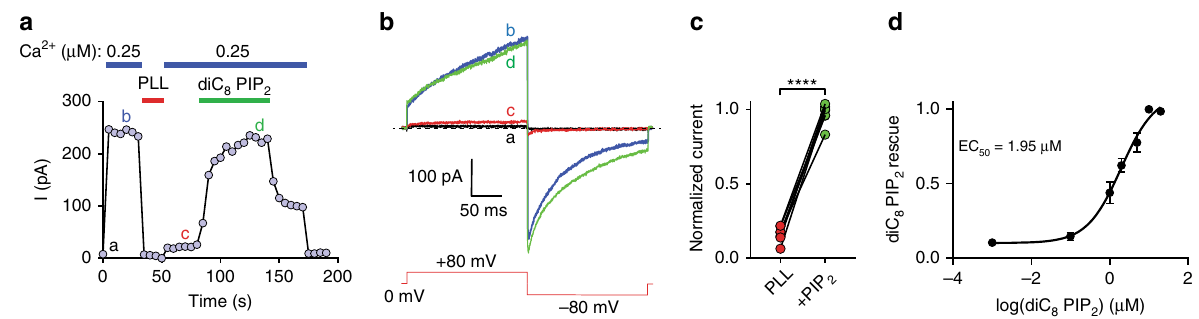
Fig. 2 PIP 2 is required for TMEM16A ’ s channel activation under sub-micromolar Ca 2 + . a , b Representative time-course recording of TMEM16A under 0.25 µ M intracellular Ca 2 + (blue bar). PIP µ g/ml, red bar) and exogenous diC µ M) was applied in the 2 was depleted by poly-L-lysine (PLL, 100 8 PIP 2 (20 presence of 0.25 µ M Ca 2 + (green bar). Representative raw current traces from different time points in a are shown in b . Repeated voltage protocol shown in inset was used to elicit TMEM16A current at a 5-s interval. c Normalized current responses after PLL treatment and during rescue by 20 µ M diC 8 PIP 2 . Two-tailed paired Student ’ s t -test: p -value is < 0.0001. d Dose-response curve of diC 8 PIP 2 -mediated rescue of TMEM16A after PLL-induced channel inhibition in the presence of 0.5 µ M Ca 2 + . The half-maximal rescue concentration (EC 50 ) of diC 8 PIP 2 is 1.95 µ M. n = 6 to 12 for each diC 8 PIP 2 concentration. Data are mean ± s.e.m. Source data are provided as a Source Data fi